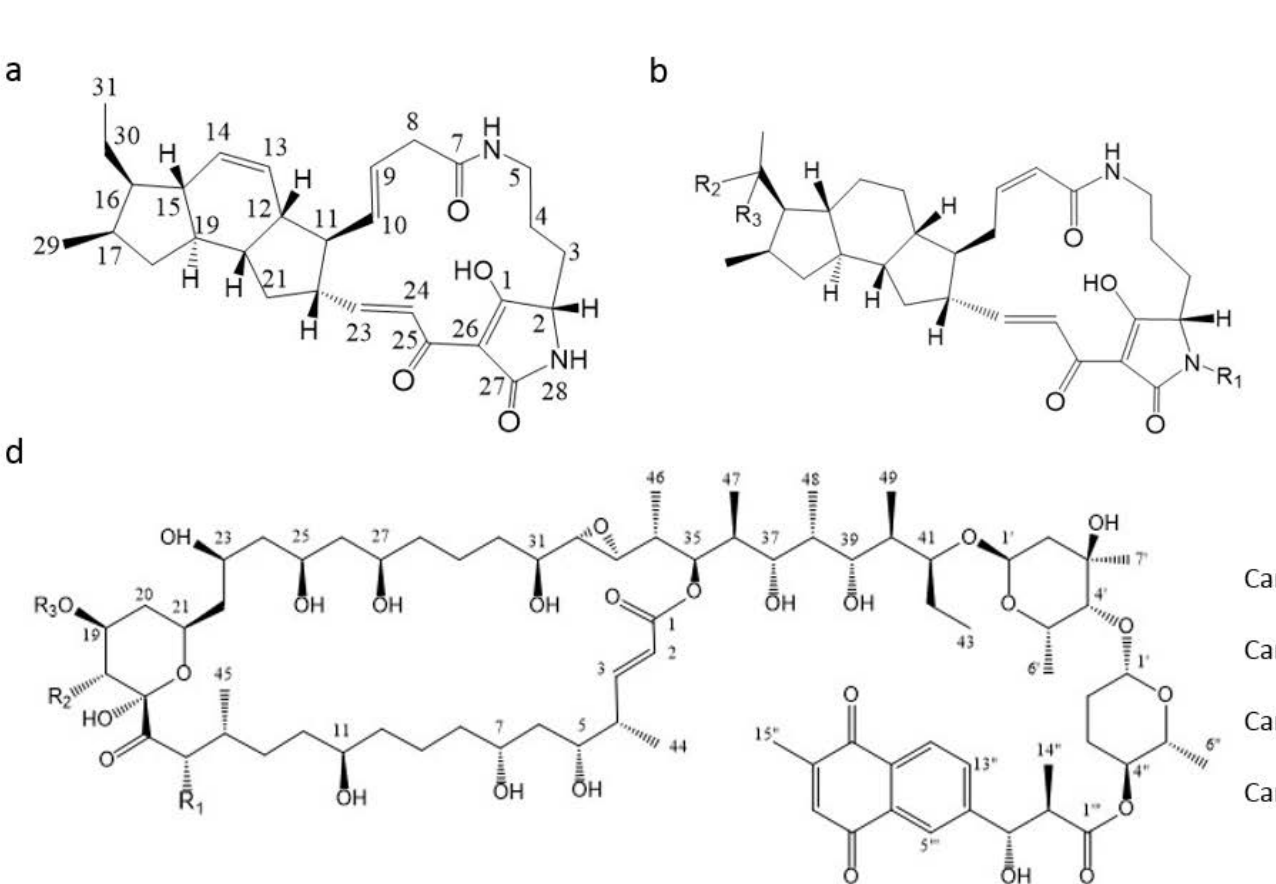
Figure 1. Chemical structures of compounds from marine bacteria with antifungal activity against A. fumigatus. ( a ) Isoikarugamycin, ( b ) 28- N -methylikaguramycin, ( c ) 4,4 (cid:48) -oxybis [3-phenylpropionic acid] and ( d ) Caniferolide